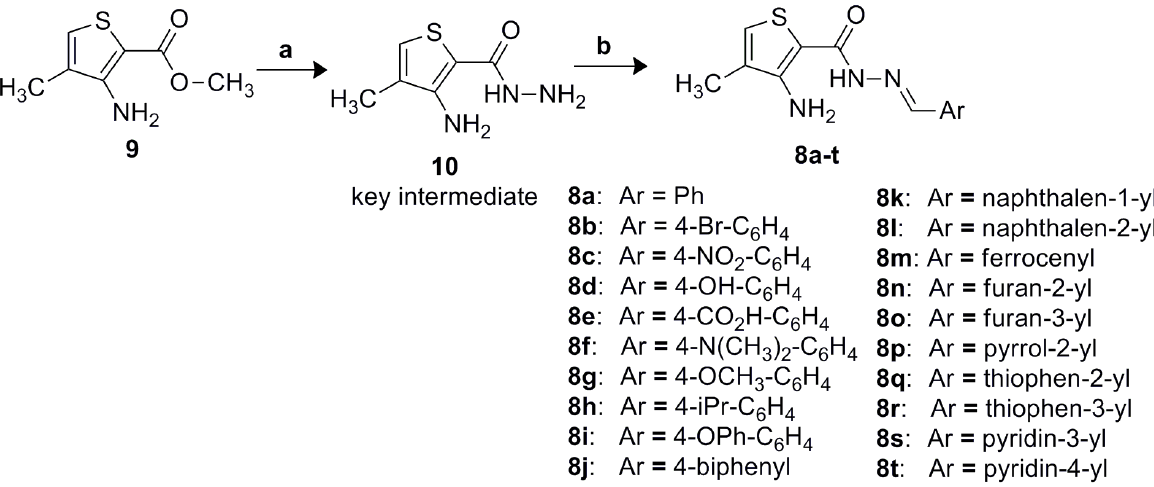
Figure 3 - General methodology for synthesis of 3-amino-4-methylthiophene-2-acylcarbohydrazones 8a-t . Reagents